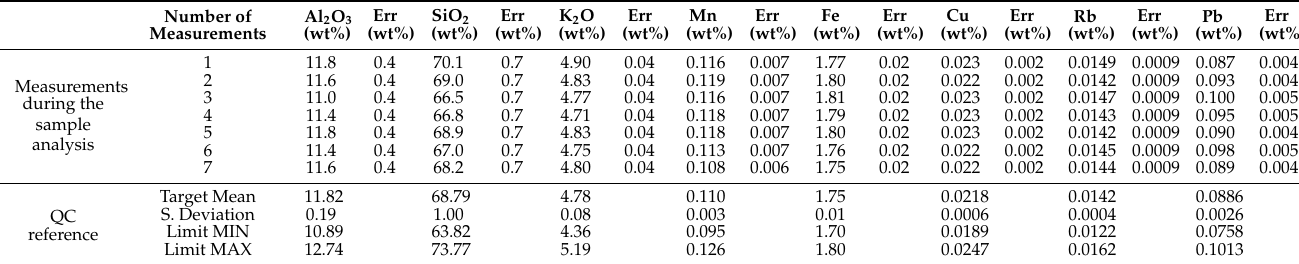
Table 2. Comparison between XRF QC analysis during the measurements ( n = 1) of the hydrothermal sample and QC reference. Err corresponds to the absolute uncertainty of the reading reported by the instrument. All measurements are shown in weight percent. Number of Measurements